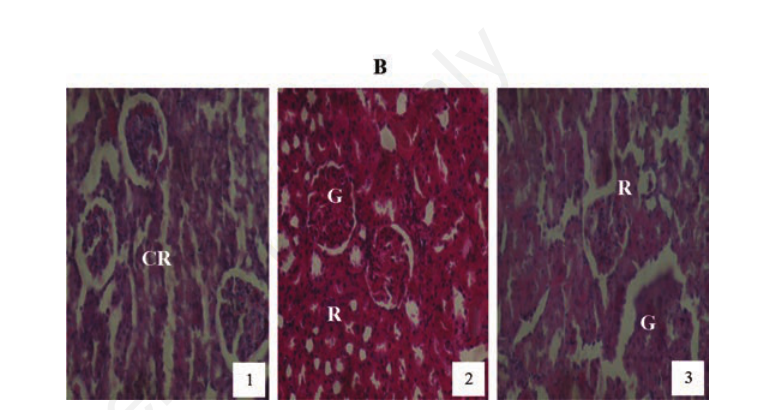
Figure 8. Hematoxylin and eosin staining after administration of 2 mg/kg of paraquat rep- resenting test subgroups maintained with ordinary drinking water with negligible vitamin C content for a period of 3 months (original magnification 400X). The slide at month (1) is showing a picture of congested renal veins and renal tubules (CR), progressing to shrunk- en Bowman’s capsules and glomerular (G) and renal vascular congestion (R) at month (2). At month (3) the picture indicated advanced renal tubular atrophy (R) with glomerular (G) and tubular degeneration. Changes increased in an exposure time dependent manner.